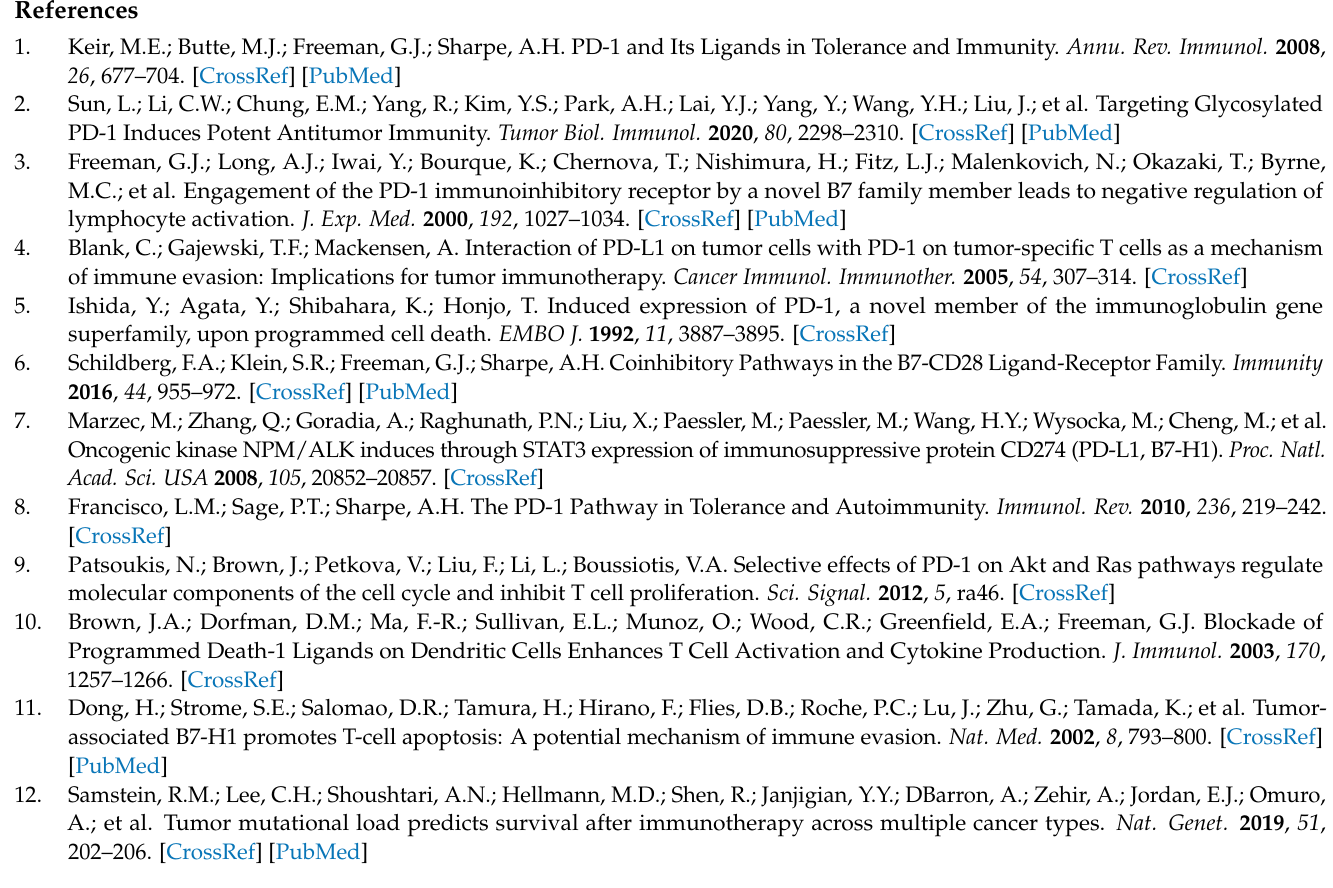
Table S1: Antibody concentrations in matrix titration experiment; Table S2: Comparison of Signal- to-Noise Ratios for the selected finally antibody concentrations on standard and high bind plate for all three assays; Table S3: Final assay conditions for PD-1, PD-L1 and PD-L2; Table S4: Results of the recovery of spiked PD-1, PD-L1 and PD-L2 concentrations in plasma samples applying a serial